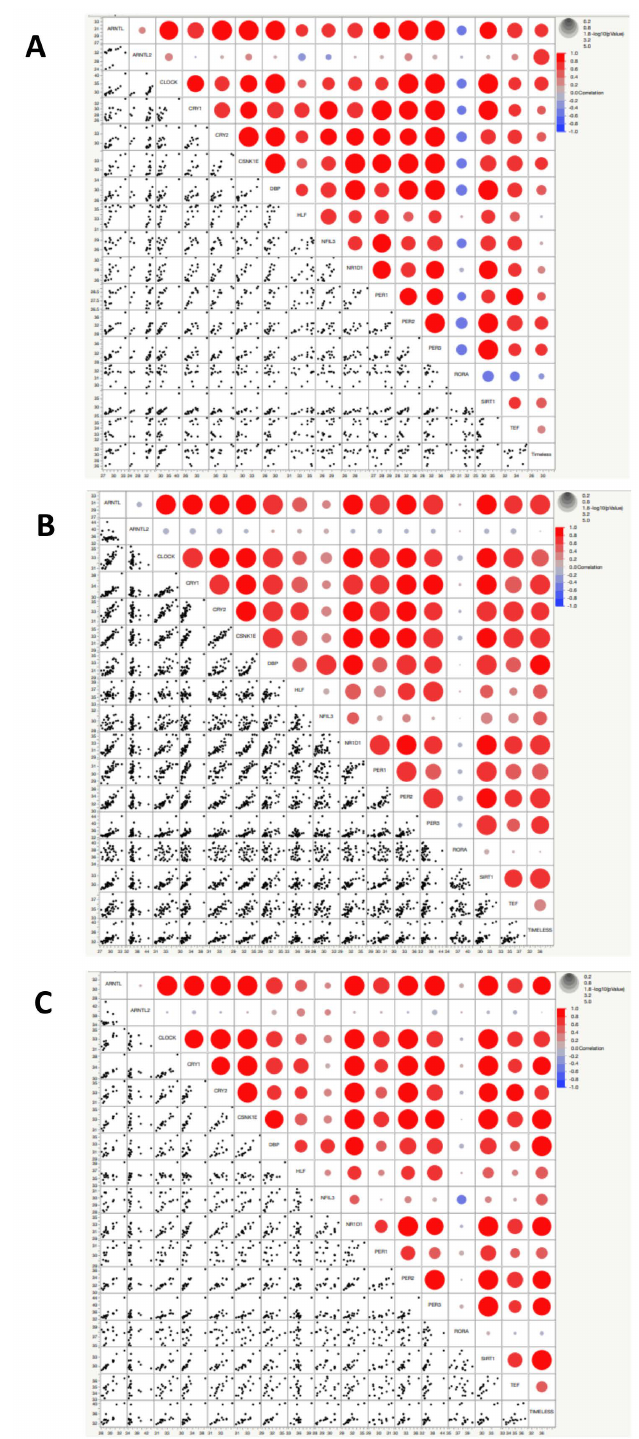
Figure 3. Correlation matrices showing correlation values between the expression of circadian genes in controls ( A ), grouped patients affected by porphyrias ( B ), symptomatic patients affected by porphyrias ( C ). The heat maps show the correlation coefficients, which measure the degree of the linear relationship between each pair of variables. The correlation values can fall between − 1 and +1. Positive correlation is measured on a 0.1 to 1.0 scale. The range from 0.1 to 0.3 indicates weak positive correlation, the range from 0.3 to 0.5 indicates a moderate positive correlation, and the range from 0.5 to 1.0 indicates a strong positive correlation. Bubble size represents statistical significance expressed as − Log “ p -value” (log-rank test), where the larger the size, the greater the